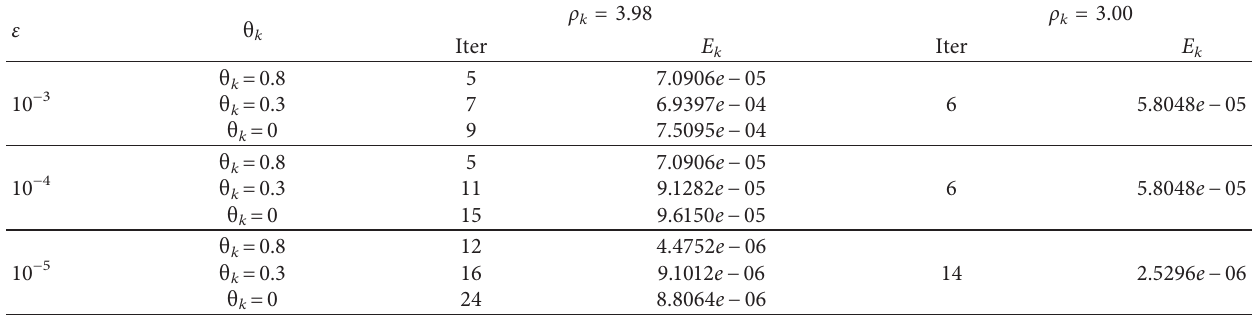
Table 1: Algorithm 1 for different choices of θ